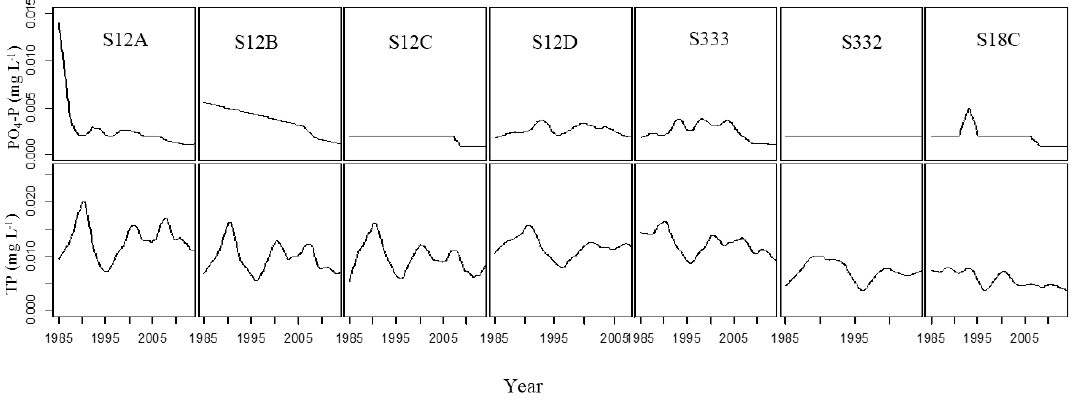
Figure 4. Trend changes in PO 4 –P and TP at seven stations.